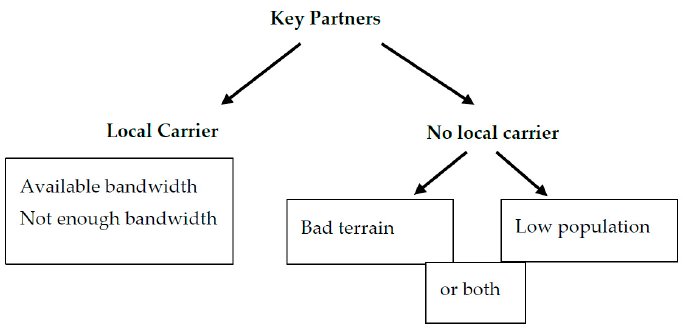
Figure 2. Key partners.